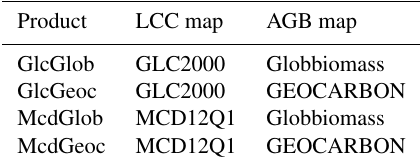
Table 1. BB emissions estimates and the LCC and AGB data